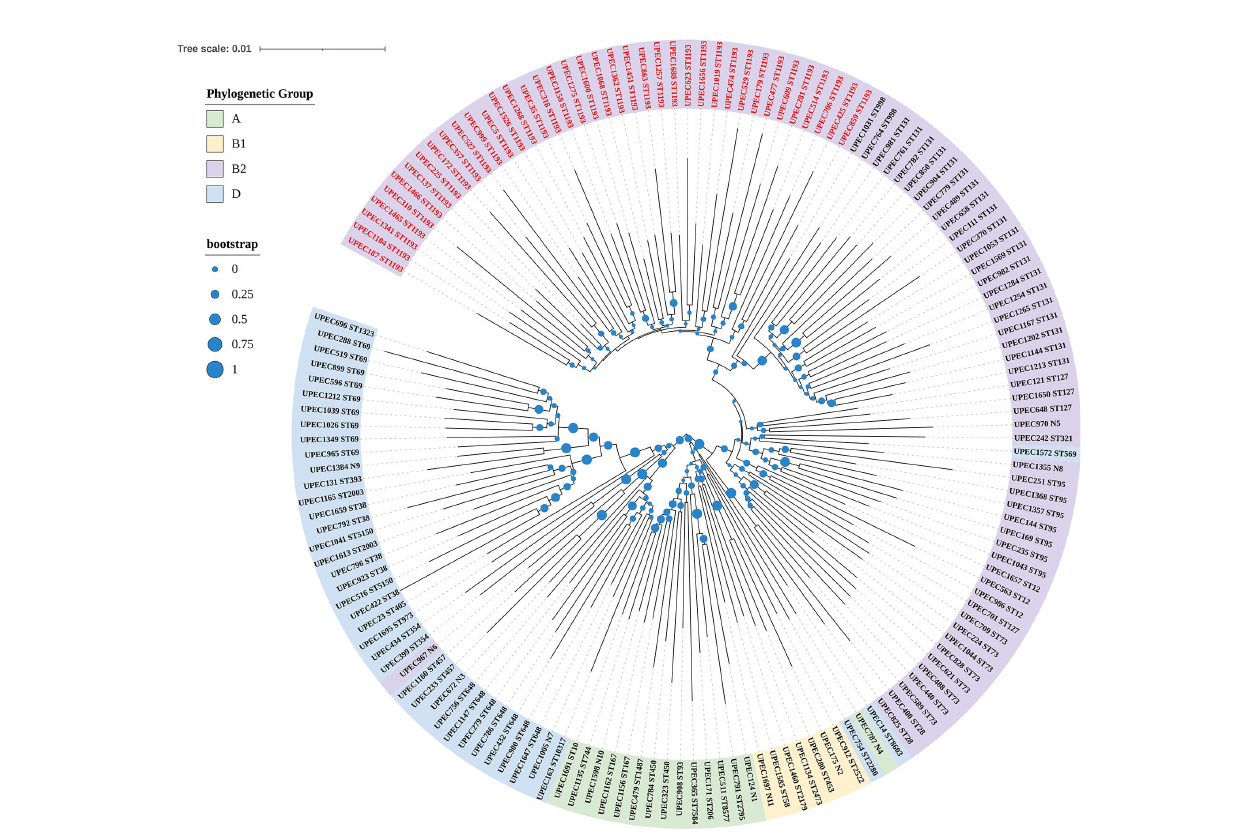
FIGURE 1 | Phylogenetic tree of UPEC isolated from female patients based on seven conserved housekeeping genes. In the tree, the UPEC of different colored regions belonged to different phylogenetic groups, and the numbers after UPEC were made up when we collected the isolates clinically. There were 50 different sequence types and N1 to N11 were represented for new ST types. The most prevalent sequence type was ST1193 and UPEC identi fi ed as ST1193 were marked in bright